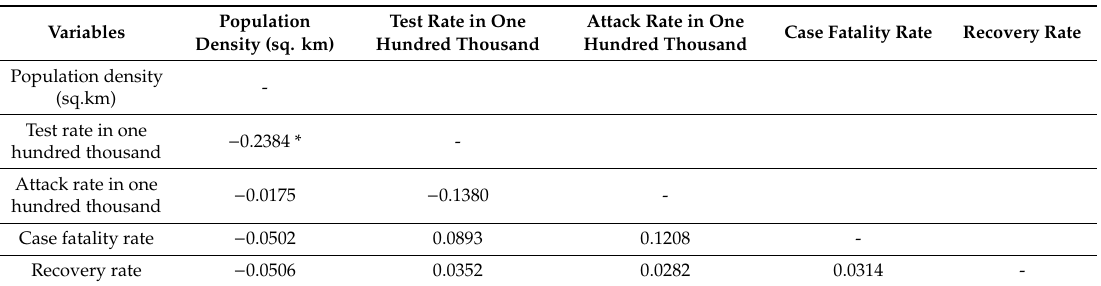
Table 1. Correlation analysis between population density rate and COVID-19 test, attack, fatality, and recovery